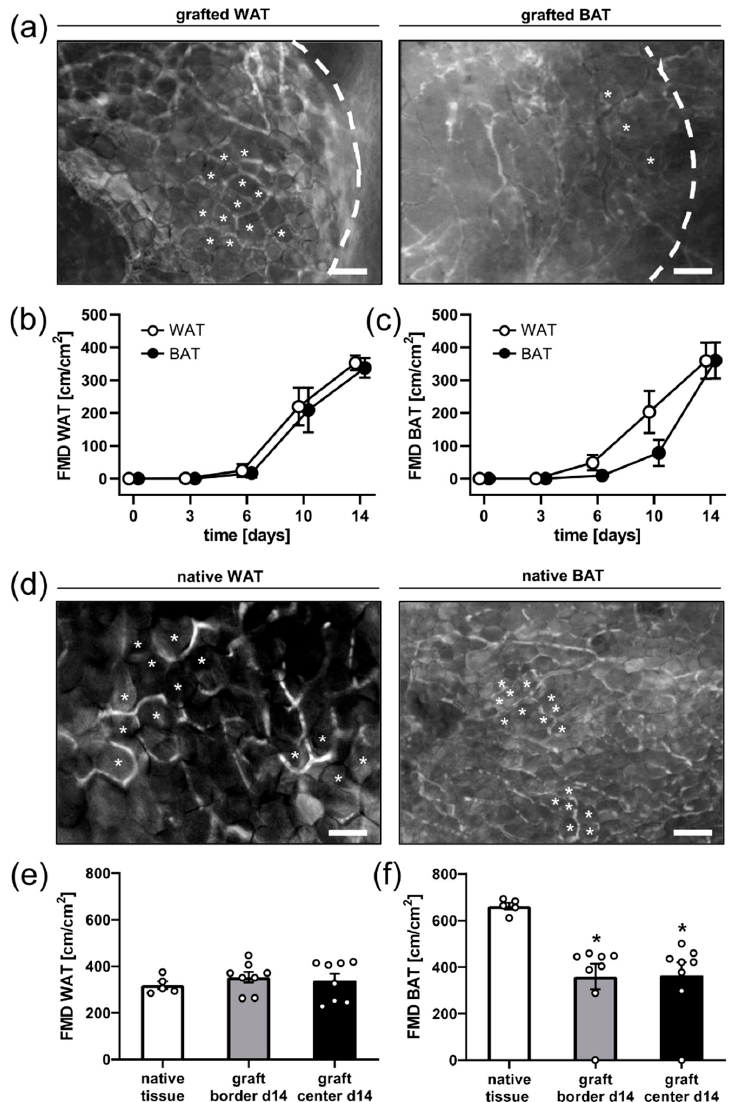
Figure 2. ( a ) Representative intravital fluorescence microscopic images (blue light epi-illumination with 5% FITC-labeled dextran for contrast enhancement) of a WAT and a BAT graft on day 14 after transplantation (broken lines = graft borders). Note that the WAT graft presents as homogenous adipose tissue, which typically consists of a dense network of microvessels surrounding individual adipocytes (asterisks) in a regular fashion. BAT grafts are characterized by a chaotic vessel architecture and only a few clearly identifiable adipocytes (asterisks). Scale bar: 50 μ m. ( b , c ) FMD in the border (n = 8) and center (n = 8) of WAT grafts ( b ) and BAT grafts ( c ) on day 0, 3, 6, 10, and 14 after transplantation, as assessed by intravital fluorescence microscopy. Mean ± SEM. ( d ) Representative intravital fluorescence microscopic images (blue light epi-illumination with 5% FITC-labeled dextran for contrast enhancement) of native WAT and BAT. Both tissues display a network of microvessels surrounding individual adipocytes (asterisks) in a regular fashion. The density of these microvessels is markedly higher in native BAT compared to WAT. Scale bar: 50 μ m. ( e , f ) FMD of native tissue (white bars; n = 5) as well as the border (grey bars; n = 8) and center (black bars; n = 8) of WAT ( e ) and BAT ( f ) grafts on day 14 after transplantation, as assessed by means of intravital fluorescence microscopy. Mean ± SEM; * p < 0.05 vs. native tissue.